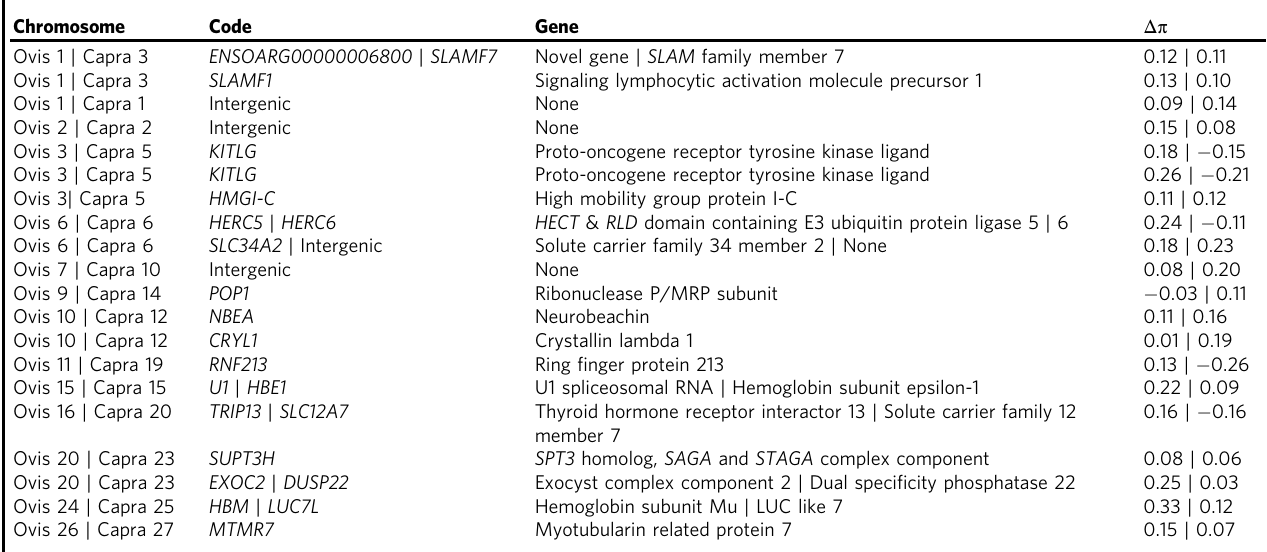
Table 1 Homologous genomic regions differentiating wilds from domestics in Ovis and Capra